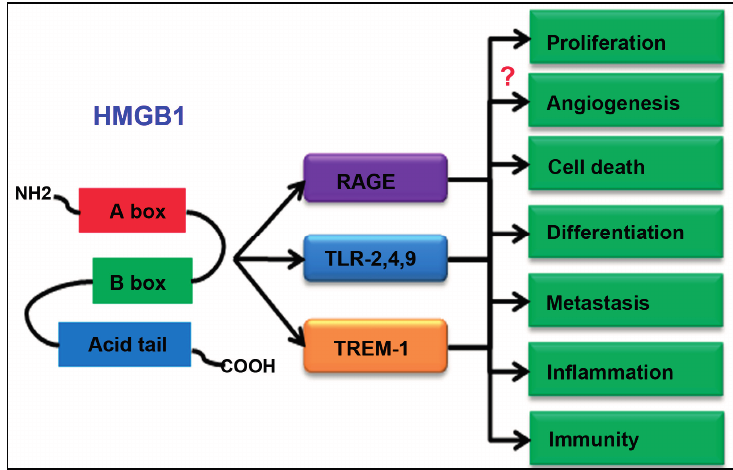
Figure 1. Schematic diagram of high mobility group protein B1 (HMGB1) signaling